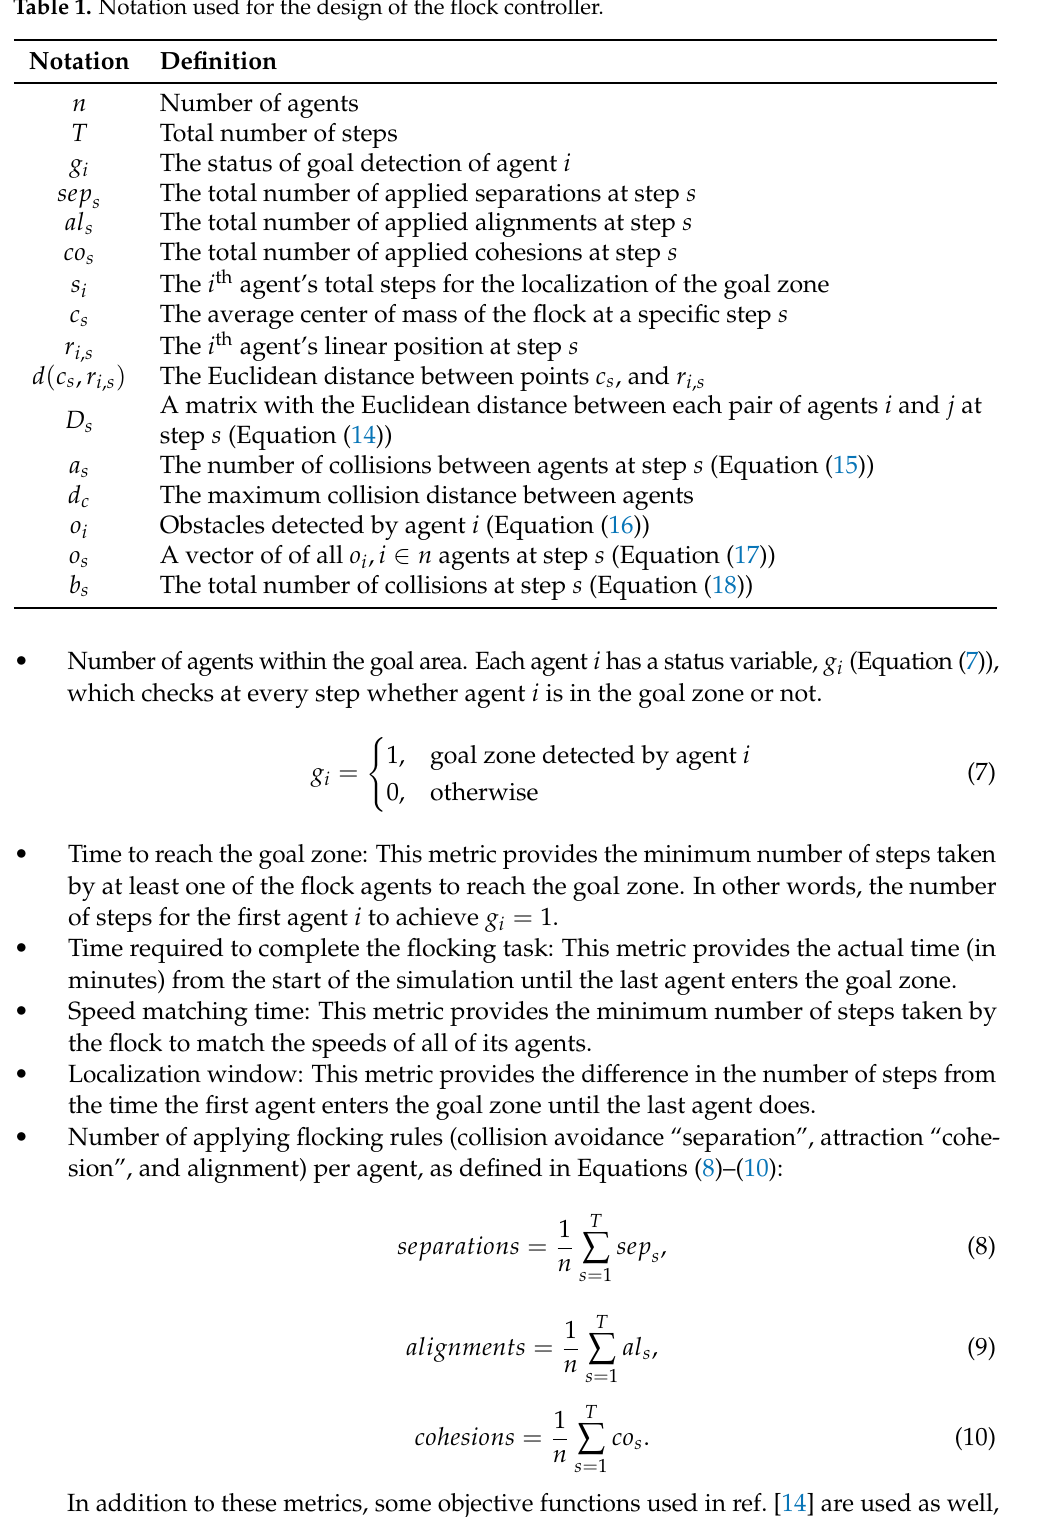
Table 1. Notation used for the design of the flock